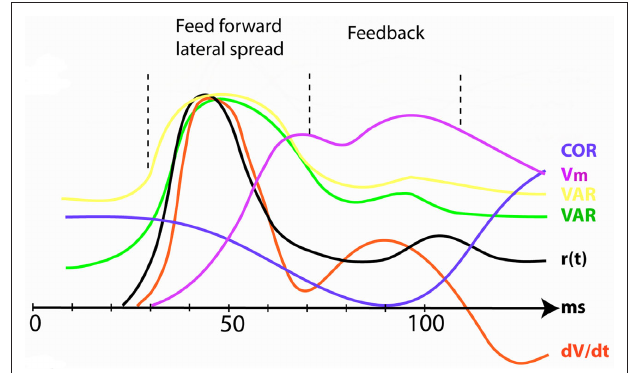
Figure 4 | The increase and reduction in dimensionality at the mapping site of the object in visual area 17 after introduction of a stationary object at time 0. COR correlation in r ( t ) between pairs of neurons (Smith and Kohn, 2008). V population membrane voltage. VAR (yellow) variance of the m population membrane potential (calculated from Roland et al., 2006); VAR (green) trial-by-trial variance in the firing rate (Gawne et al., 1996); r ( t ) firing rate; d V /d t time derivative of membrane potential V (proportional to net membrane current); (Eriksson et al., 2008). As the variance decrease and the correlations increase in the feedback interval the dimensionality reduces. All data normalized to maximum